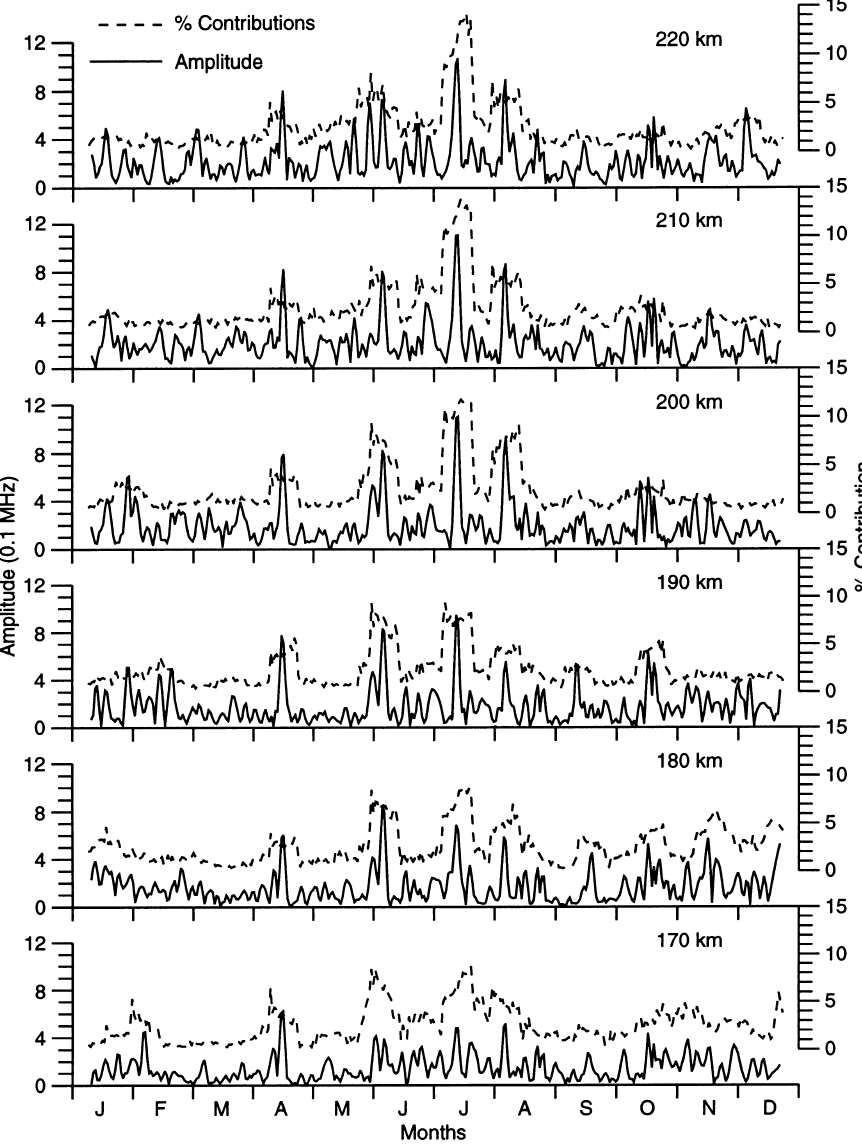
Fig. 5. Annual variations of the in- stantaneous amplitude ( solid line ) and percentage contributions of spectral energy ( dashed line ) for the quasi-2-day oscillation in the ionospheric plasma frequency during 1995. The left y-axis represents the quasi-2-day amplitude and the right y-axis their spectral